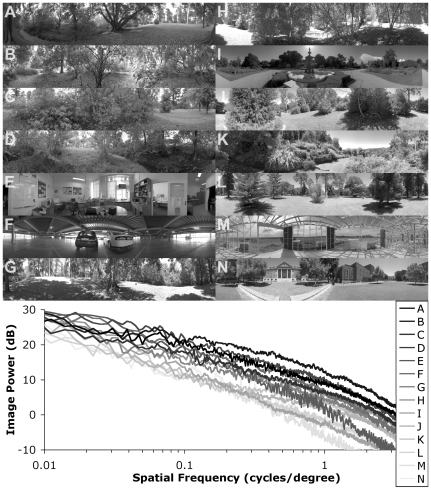
Panoramic input images.(upper) The model used high-dynamic range inputs however they have been normalized, gamma corrected and reduced to 8-bits of dynamic range for reproduction here. Images are ranked from highest to lowest contrast based on the raw elementary motion detection contrast measure (CEMD: see text for details) and cover a wide range of different environments and lighting conditions. Real world brightness (Cd/m2) and contrast values are given in Table 1. Only the green channel of the images (shown) was used as inputs to the model. (lower) Average 1D row power spectra of the 14 natural panoramic images used as inputs to the motion processing model. All have an approximately linear relationship between power and spatial frequency (on the logarithmic axis) common in natural scenes. The vertical offset (contrast) in the graphs varied almost 10dB between the different images. The roll-off at higher frequencies was caused by stitching artifacts and was outside the pass-band of the models used.